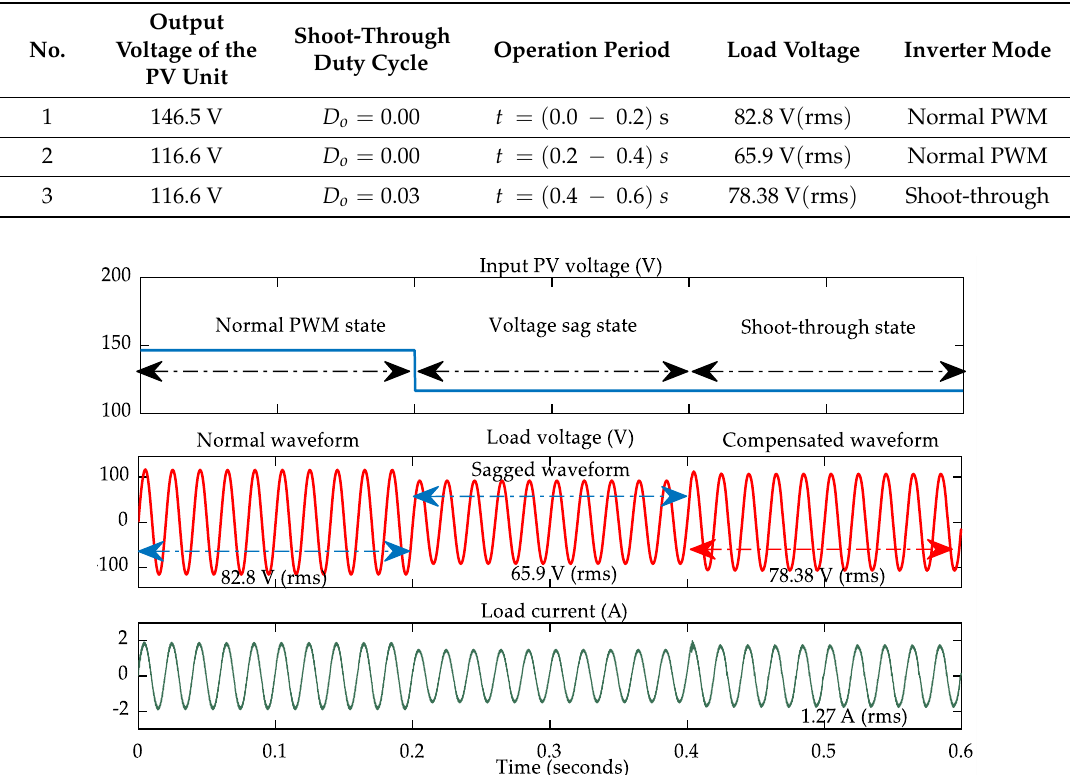
Figure 10. Simulation results during the dynamic condition.